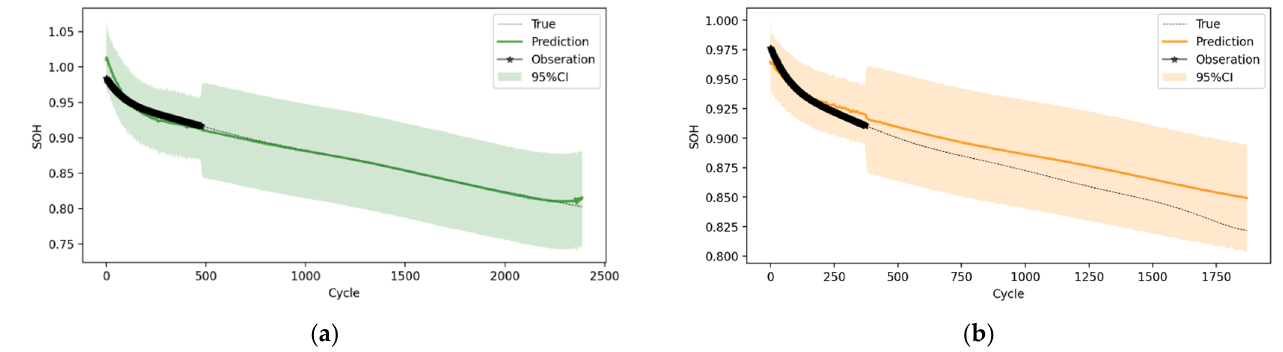
Figure 4. SOH prediction results of battery cell based on the MOGPR under different conditions: ( a ) results of MOGPR-based battery cell SOH prediction (25 °C_0.5C0.5C); ( b ) results of MOGPR-based battery cell SOH prediction (35 °C_0.3C1C).